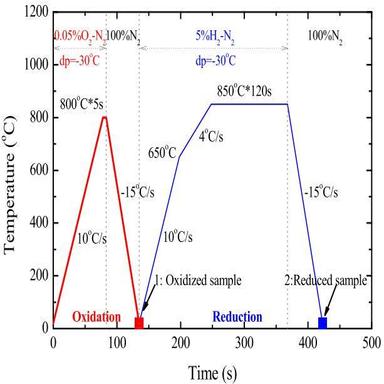
Thermal cycle of the oxidation-reduction experiments.